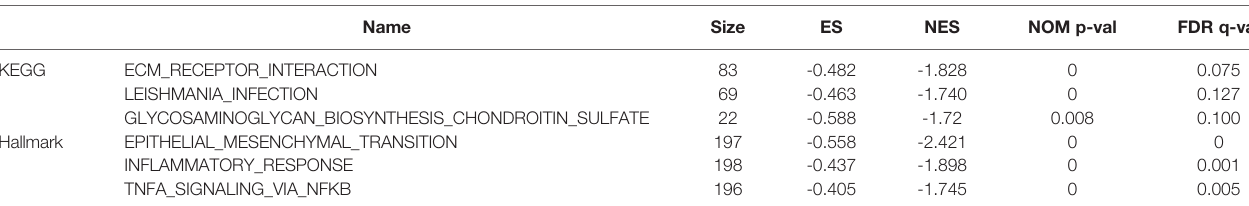
TABLE 5 | The top 10 Hallmark and KEGG pathway of IRF4.